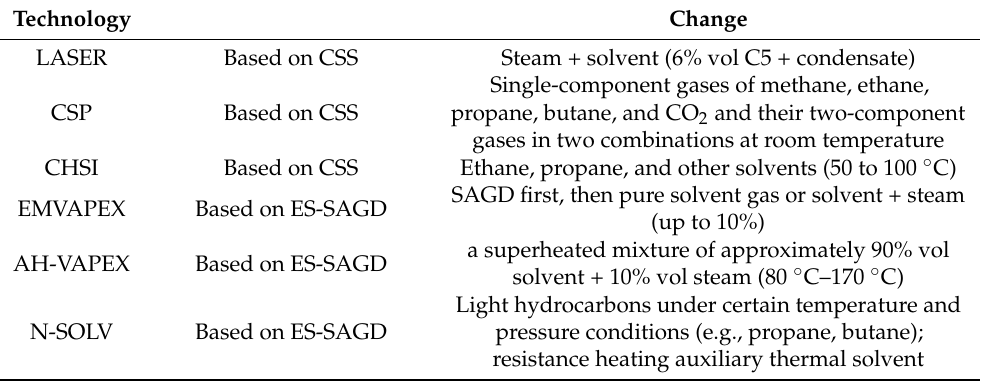
Table 1. Background of some of the technologies and technical ideas. Technology Change LASER Based on CSS Steam + solvent (6% vol C5 + condensate) Single-component gases of methane, ethane, CSP Based on CSS propane, butane, and CO 2 and their two-component gases in two combinations at room temperature CHSI Based on CSS Ethane, propane, and other solvents (50 to 100 ◦ C) SAGD first, then pure solvent gas or solvent + steam EMVAPEX Based on ES-SAGD (up to 10%) a superheated mixture of approximately 90% vol AH-VAPEX Based on ES-SAGD solvent + 10% vol steam (80 ◦ C–170 ◦ C) Light hydrocarbons under certain temperature and N-SOLV Based on ES-SAGD pressure conditions (e.g., propane, butane); resistance heating auxiliary thermal